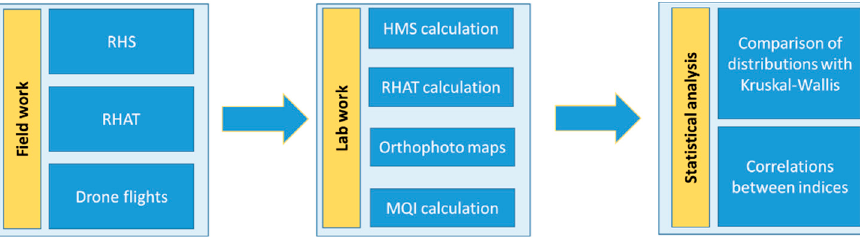
Figure 2. Flowchart showing the main methodological steps followed in this study.